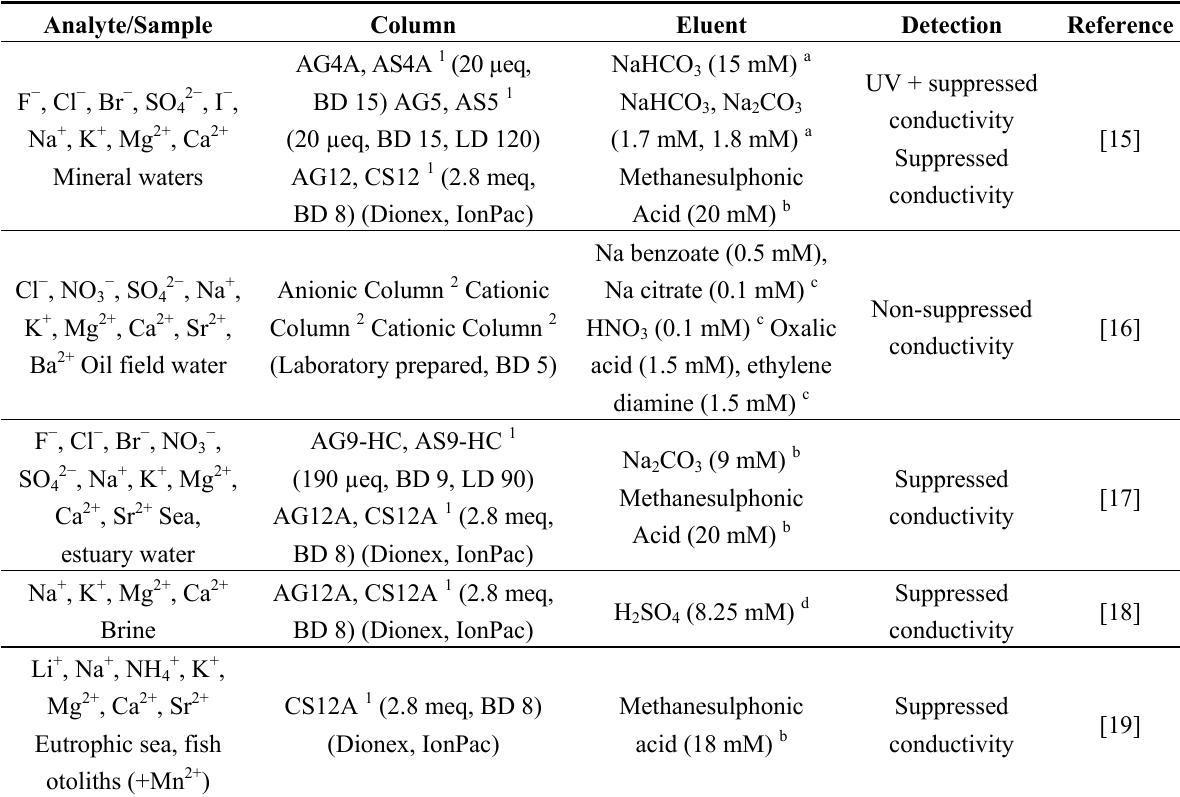
Table 1. Anionic and/or cationic composition of waters with high ionic strength determined as completely as possible with ion